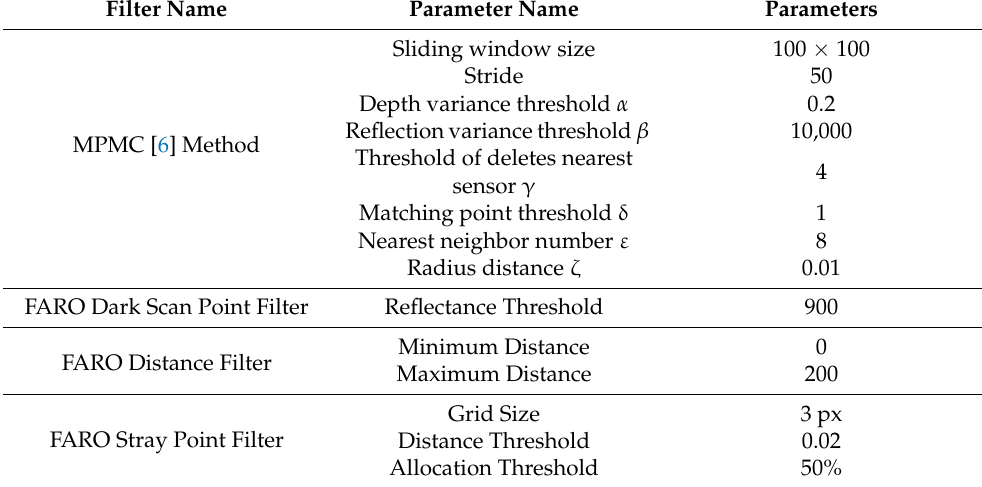
Table 5. MPMC method and FARO SCENE filter parameters.